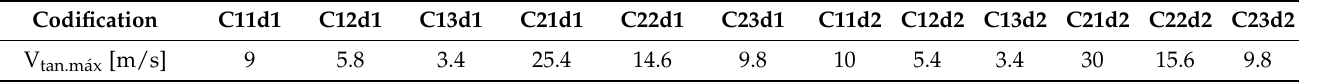
Table A2. Cases studied and their corresponding maximum concentration within the elbow.